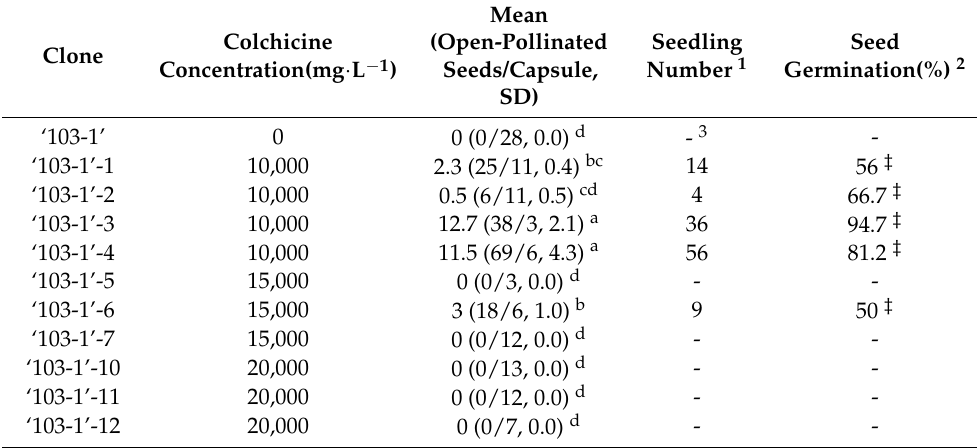
Table 3. Maternal fertility of colchicine-treated ‘103-1’ ( Kalanchoe garambiensis ‘Type 1’ × K. nyikae ) could be restored based on observation of seed production and germination after open pollination.